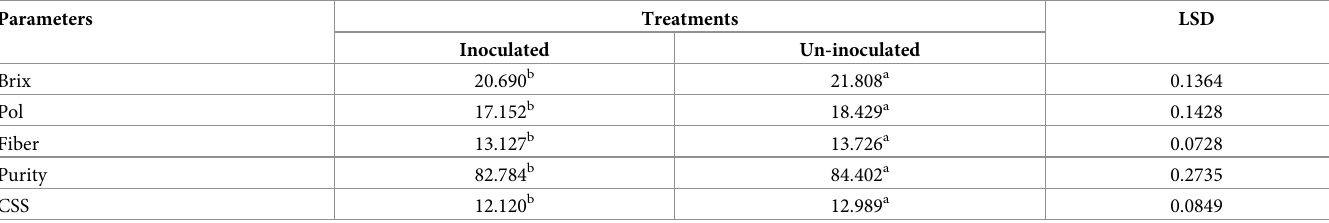
Table 3. The main effects of disease treatments on average qualitative parameters of sugarcane cultivars.